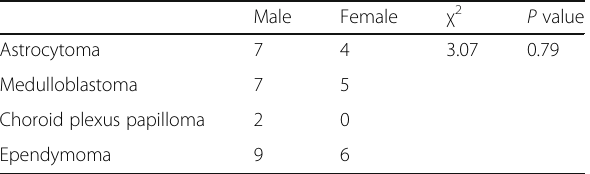
Table 1 Correlation between sex and pathological types